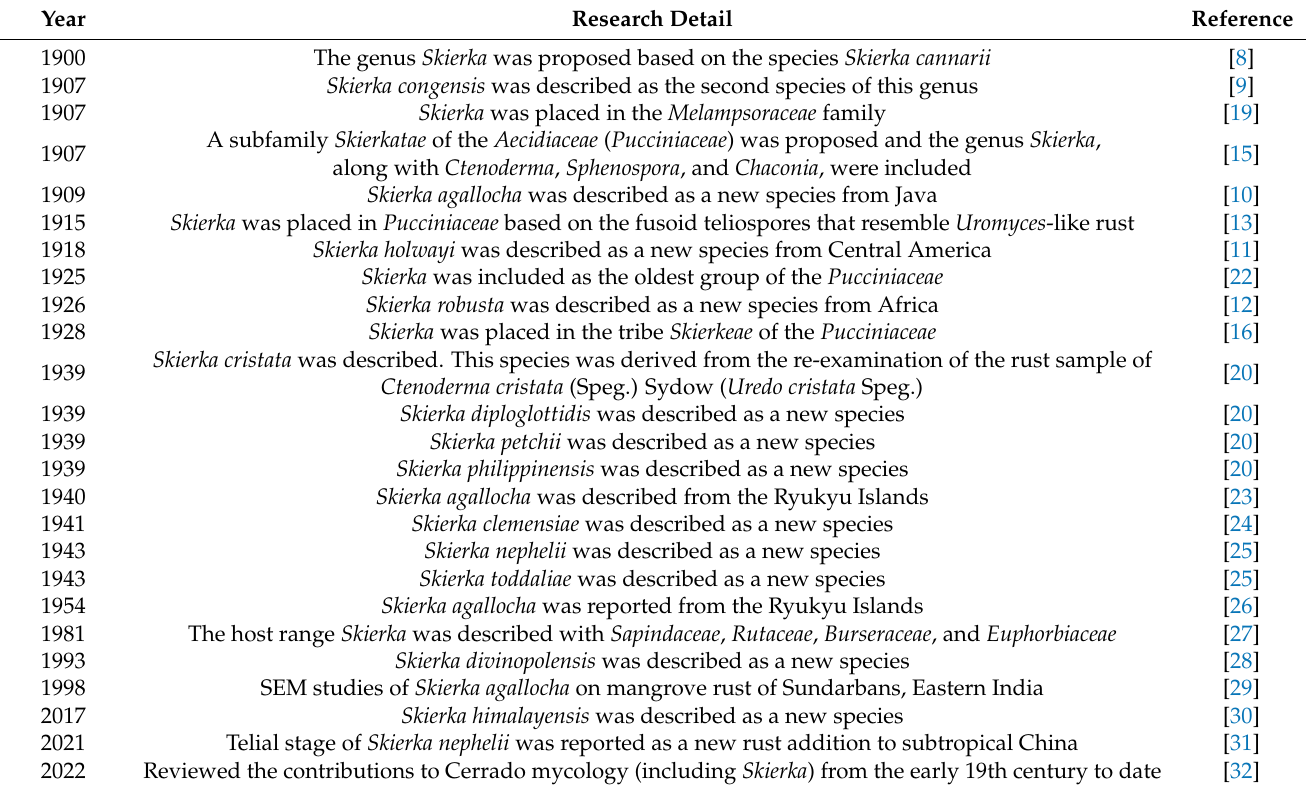
Table 1. The detailed history of the genus Skierka